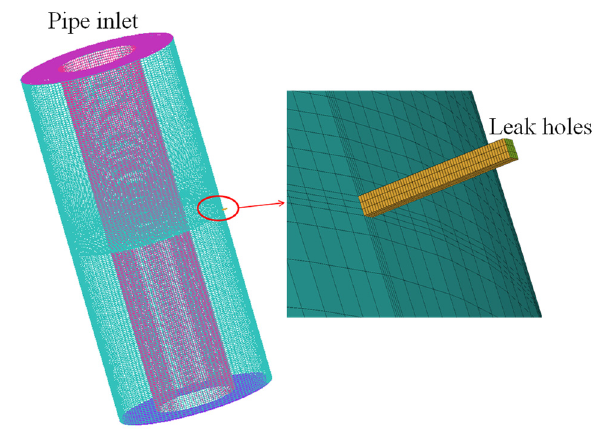
Figure 2. Grid partition overview.